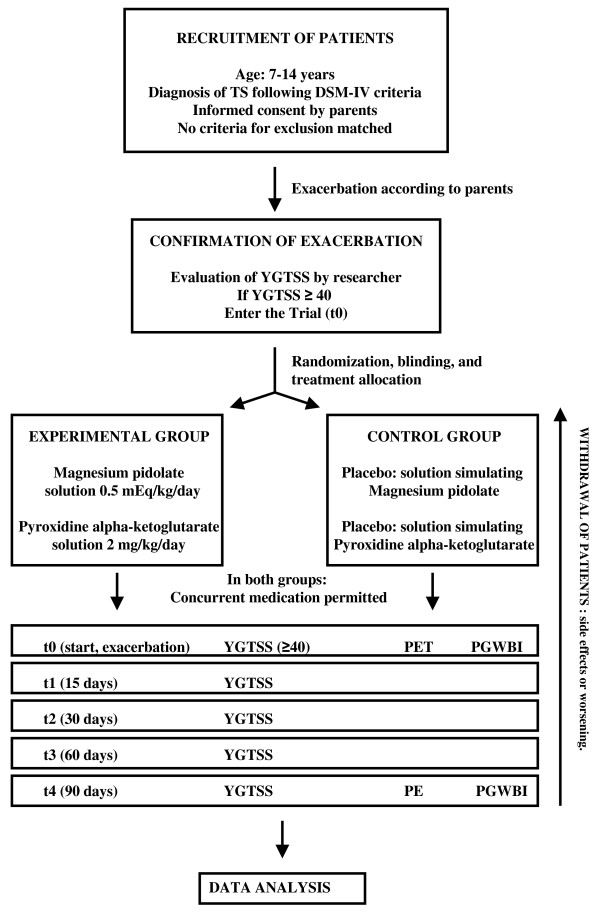
Patients flowchart.